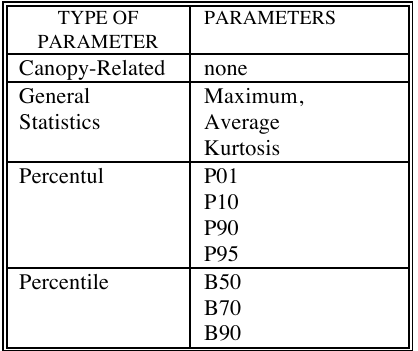
Table 4: Parameters Used in the Best DBH Estimation